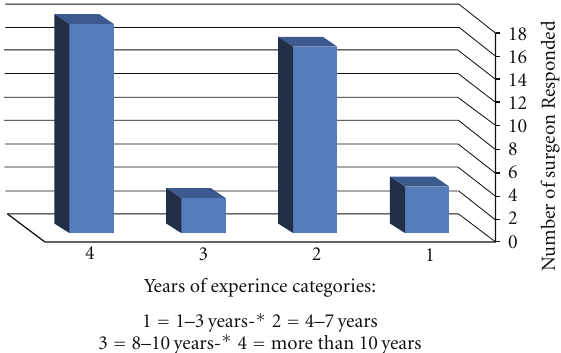
Figure 2: Bar chart representing the experience in thyroid surgery across the 41 units.